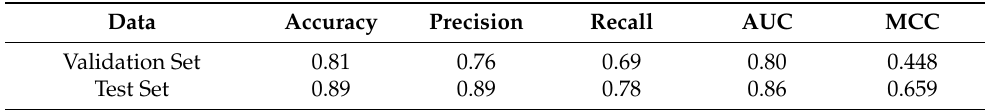
Table 2. Prediction of effects on the catalytic efficiency of hydrolases by residue mutation on valida- tion and test set by random forest